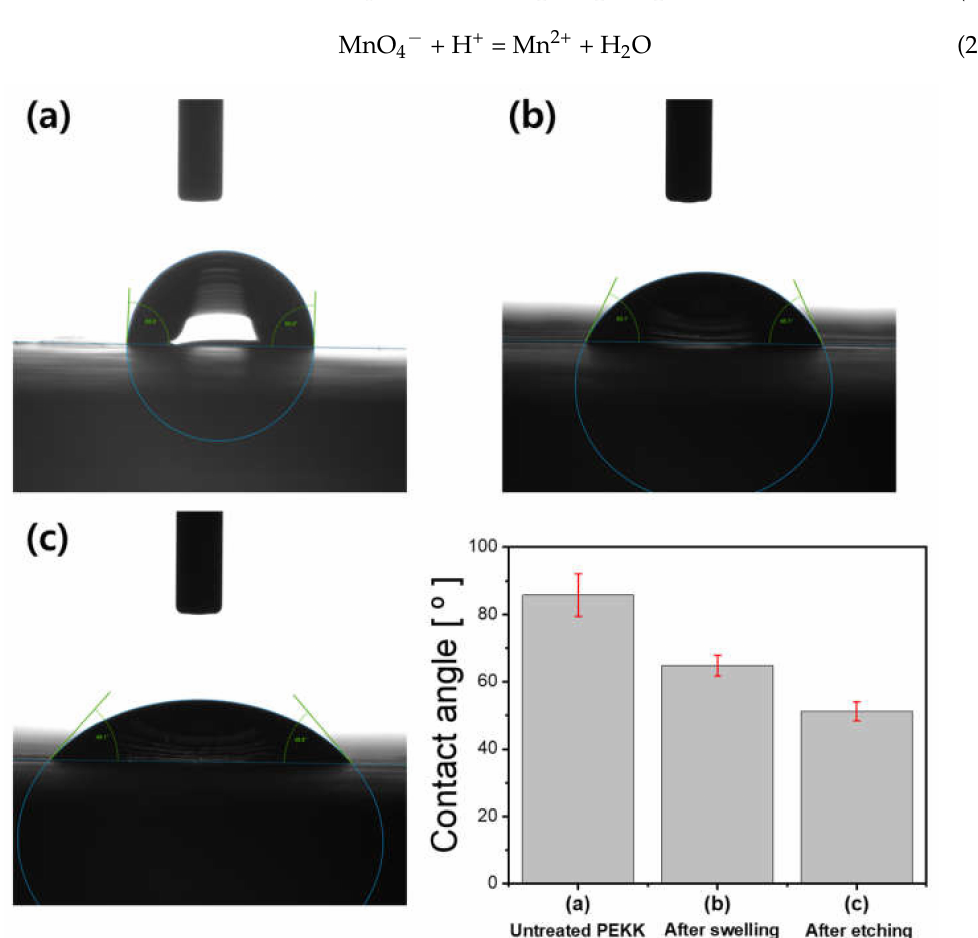
Figure 4. Contact angle measurement of a water drop on a 3D printed PEKK surface for comparing chemical treatment: ( a ) Untreated PEKK; ( b ) After H 2 SO 4 swelling; ( c ) After KMnO 4